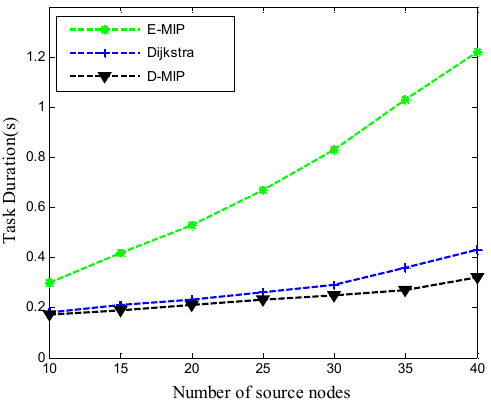
Figure 12. The effect of the number of source nodes on energy. Figure 12. The e ff ect of the number of source nodes on energy.